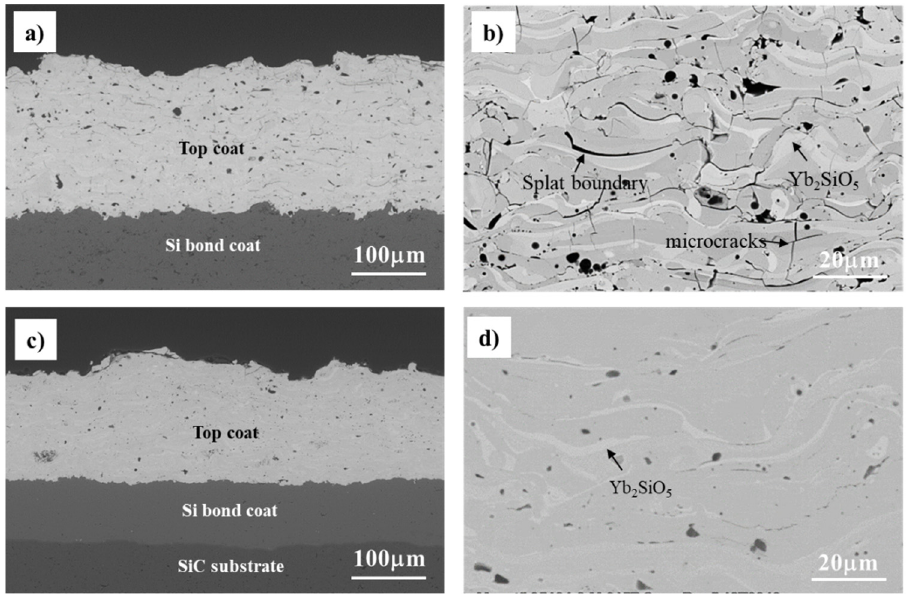
Figure 1. Typical annealed coating microstructures at low and high magnifications. ( a , b )